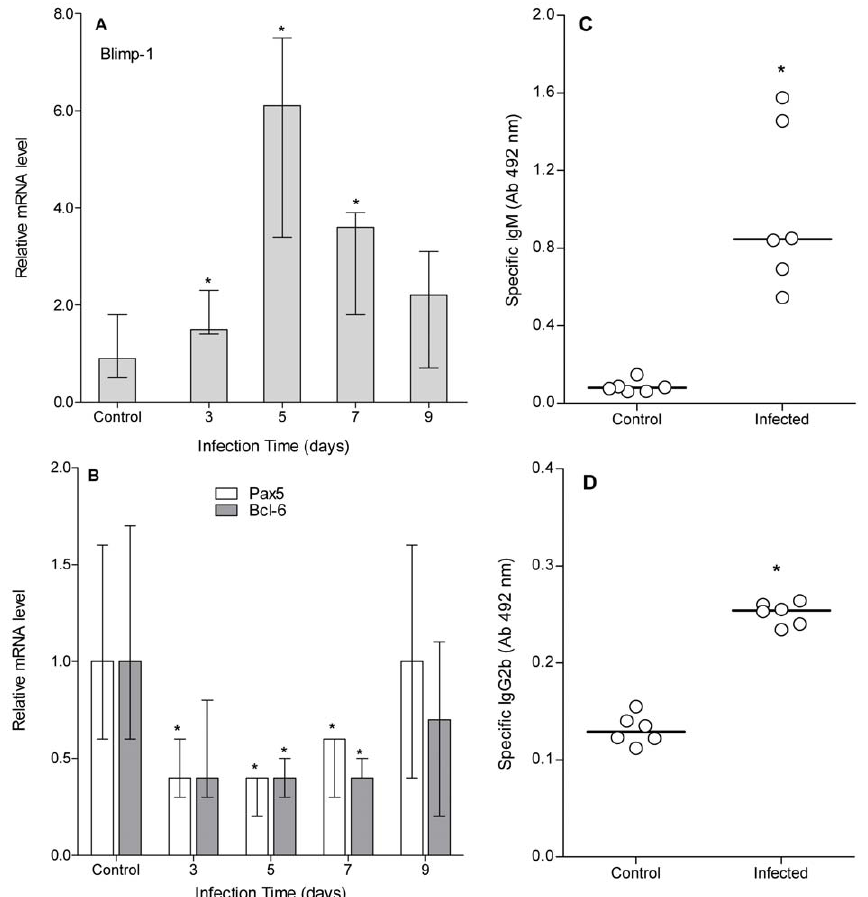
Figure 2. Peritoneal B cells drop is associated with a plasma cell differentiation process. A group of mice (n=12) was inoculated ip with 2000 protoscoleces and another group (n=8) was inoculated with equal volume of sterile PBS (control group). Three infected and 2 control animals were sacrificed at days 3, 5, 7 and 9 pi and their peritoneal cells were recovered. qRT-PCR was performed using specific primers for murine Pax5, Blimp-1 and Bcl-6, and relative mRNA levels were expressed respect to control group. Results are shown as group median and data range (A and B). Another group of infected (n=6) and control mice (n=6) were sacrificed at day 5 pi and their peritoneal leukocytes were culture for 72 h in complete RPMI without stimulation. Anti-PSA specific IgM, IgG1, IgG2a, IgG2b and IgG3 titers were determined by ELISA in culture supernatants. Results are shown as individual values (circles) and group median (lines) (C and D). (*) Statistical significance (p , 0.05) compared to control group. Results are representative of two independent